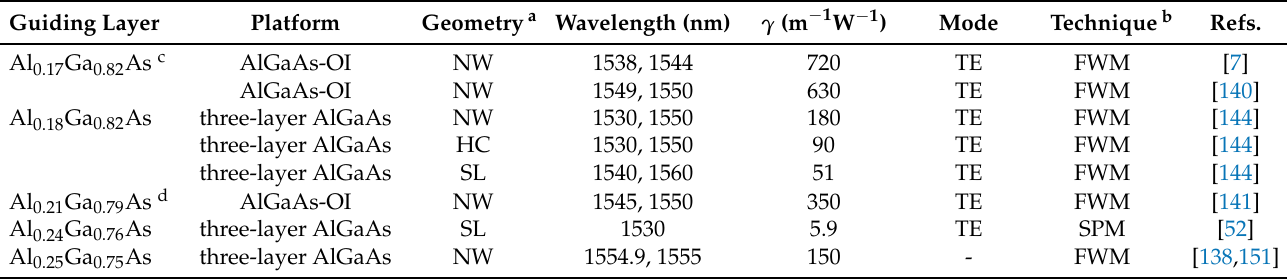
Table 2. Nonlinear coefficients of AlGaAs